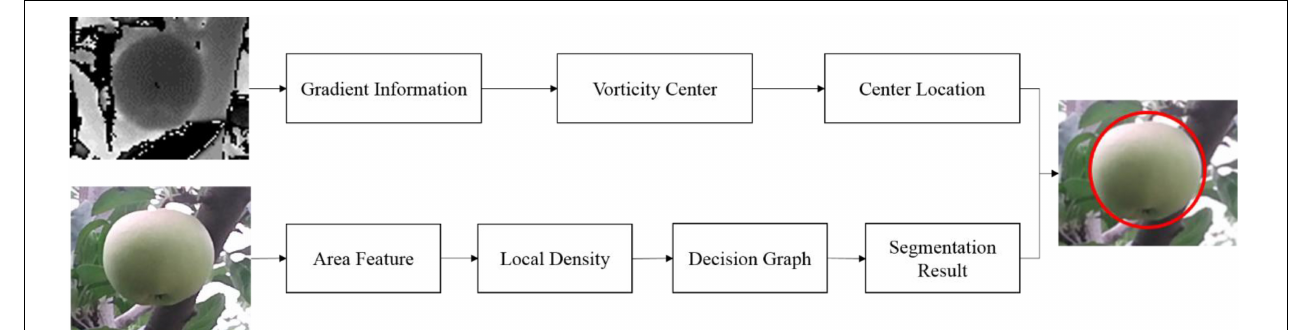
FIGURE 2 | The overview of our method.